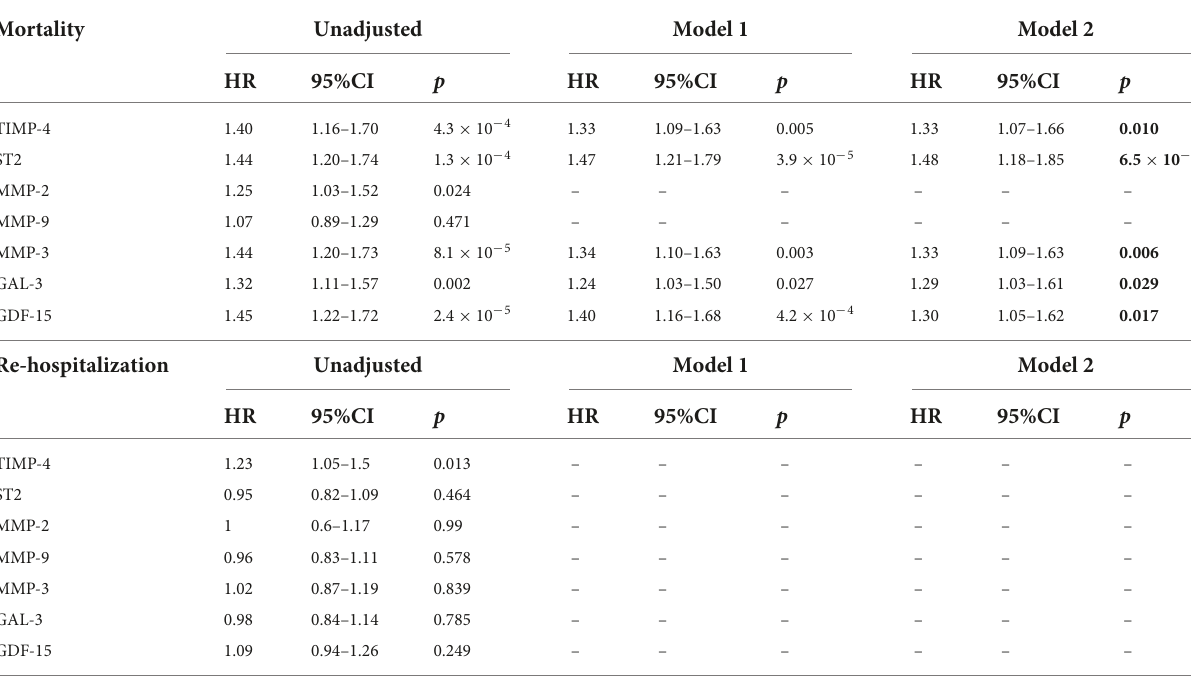
TABLE 3 Cox regression analyses display associations between myocardial fibrosis biomarkers and mortality and re-hospitalization in patients with prevalent